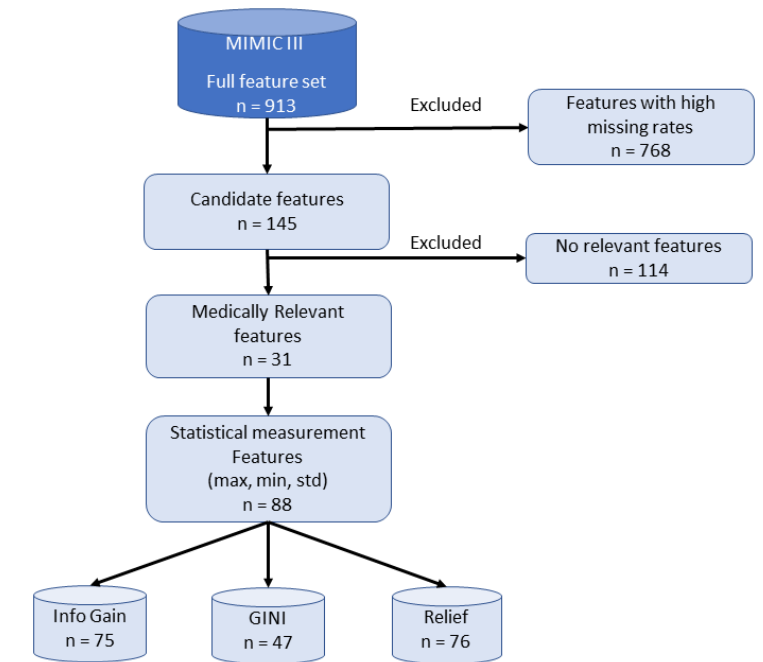
Figure 6. Feature selection